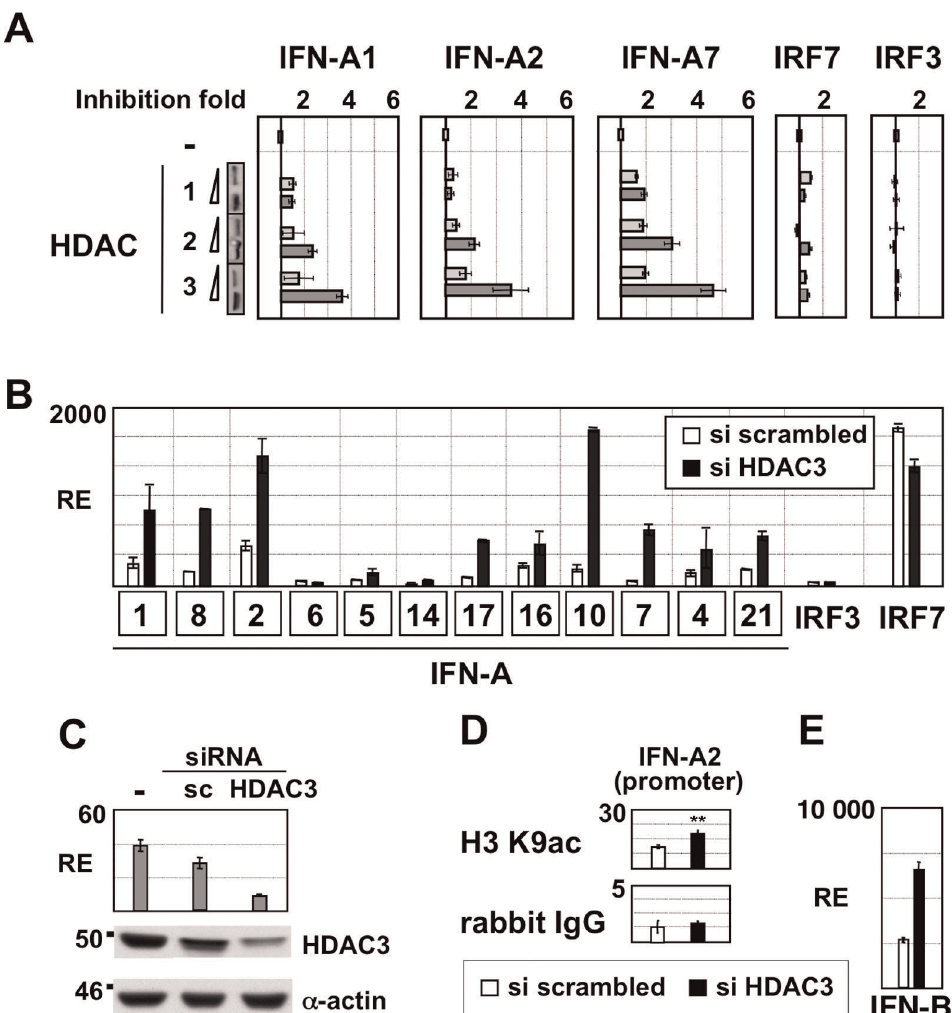
Figure 6. Inhibitory effect of HDAC3 on IFN-A gene transcription. ( A ) The effect of HDACs class I (1, 2 and 3) on IFN-A gene transcription was determined in HEK293-TLR3 cells transfected with pcDNA3-IRF7A together with an HDAC-encoding plasmid added in 2-fold increasing amounts, as indicated in Materials and Methods. After 24 h of expression, the inhibition fold was calculated from IFN-A mRNA levels determined by RT-QPCR in HDAC-expressing cells in comparison to control cells transfected with pcDNA3. HDAC expression determined by anti-flag immunoblotting of the cell lysates is shown in the insets. ( B ) HDAC3 expression was specifically inhibited for 40 h by siRNA in HEK293-TLR3 cells expressing TRAF3 and IRF7A. IFN-A gene expression was determined after HDAC3 depletion by RT-QPCR following 8 h of infection by Sendai virus and compared to the expression determined in cells transfected with scrambled siRNA oligonucleotides. ( C ) Silencing efficiency was confirmed by RT-QPCR and Western blot analyses using total RNA and proteins extracted from cells transfected with siRNA oligonucleotides specific for HDAC3 or a mixture of scrambled (sc) siRNAs. ( D ) Histone H3K9 acetylation associated with the IFN-A2 gene promoter was determined in control and HDAC3-depleted cells by quantitative ChIP assays as described in Materials and Methods. Anti-rabbit IgG was used to determine non-specific binding. ( E ) IFN-B gene expression was determined by RT-QPCR following 8 h of infection by Sendai virus in HEK293-TLR3 cells expressing TRAF3 and IRF7A and transfected with scrambled siRNA or siRNA oligonucleotides specific for HDAC3.